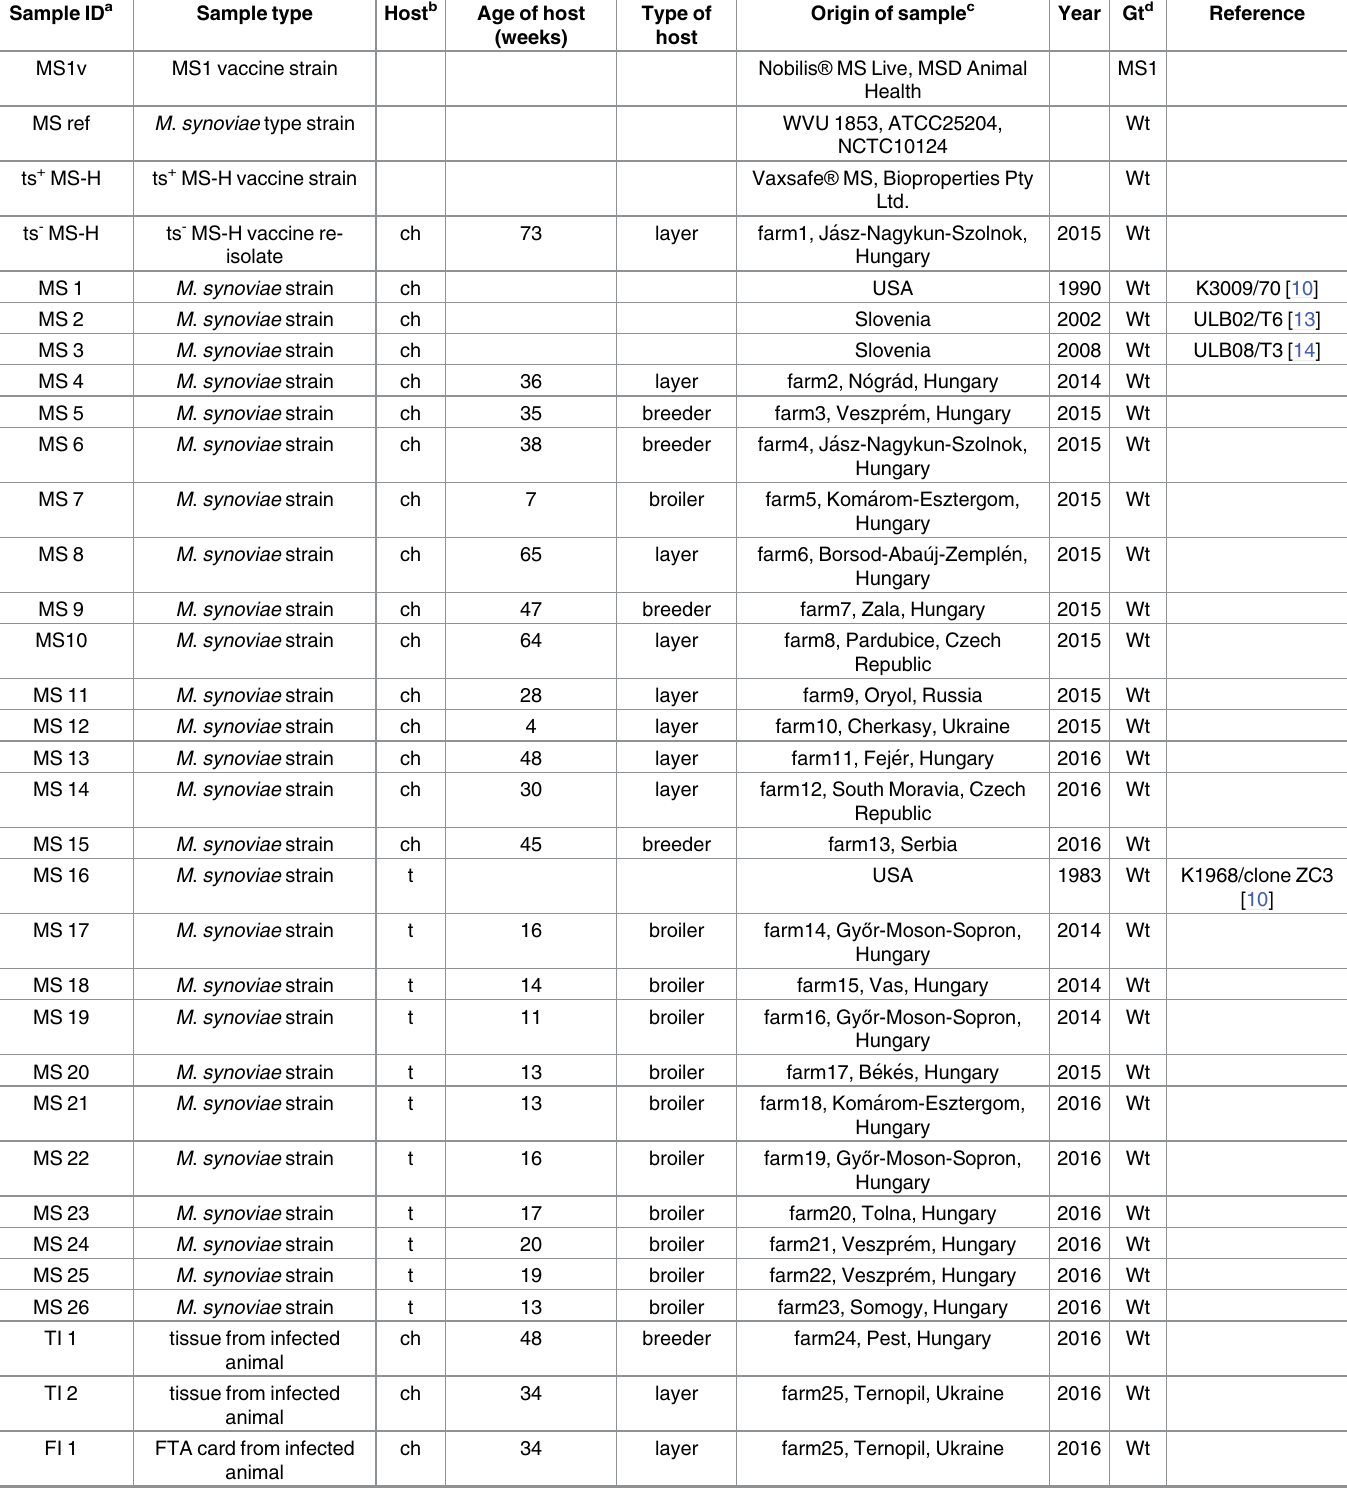
Table 1. Background information and genotype of the Mycoplasma synoviae strains and clinical samples included in this